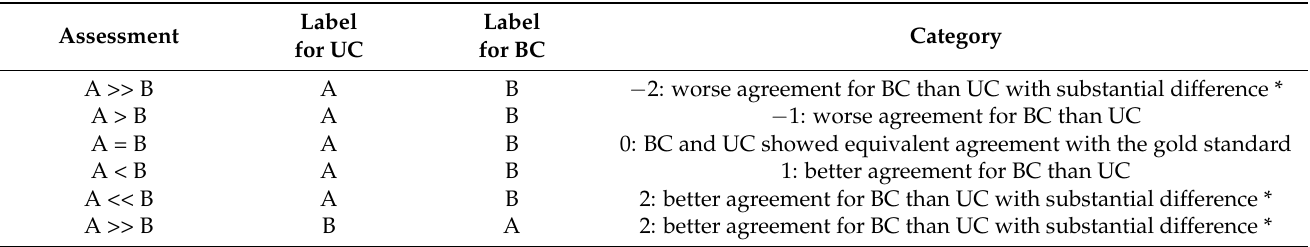
Table 1. Comparative Visual Assessment of Uncorrected vs. Bias-corrected BPE